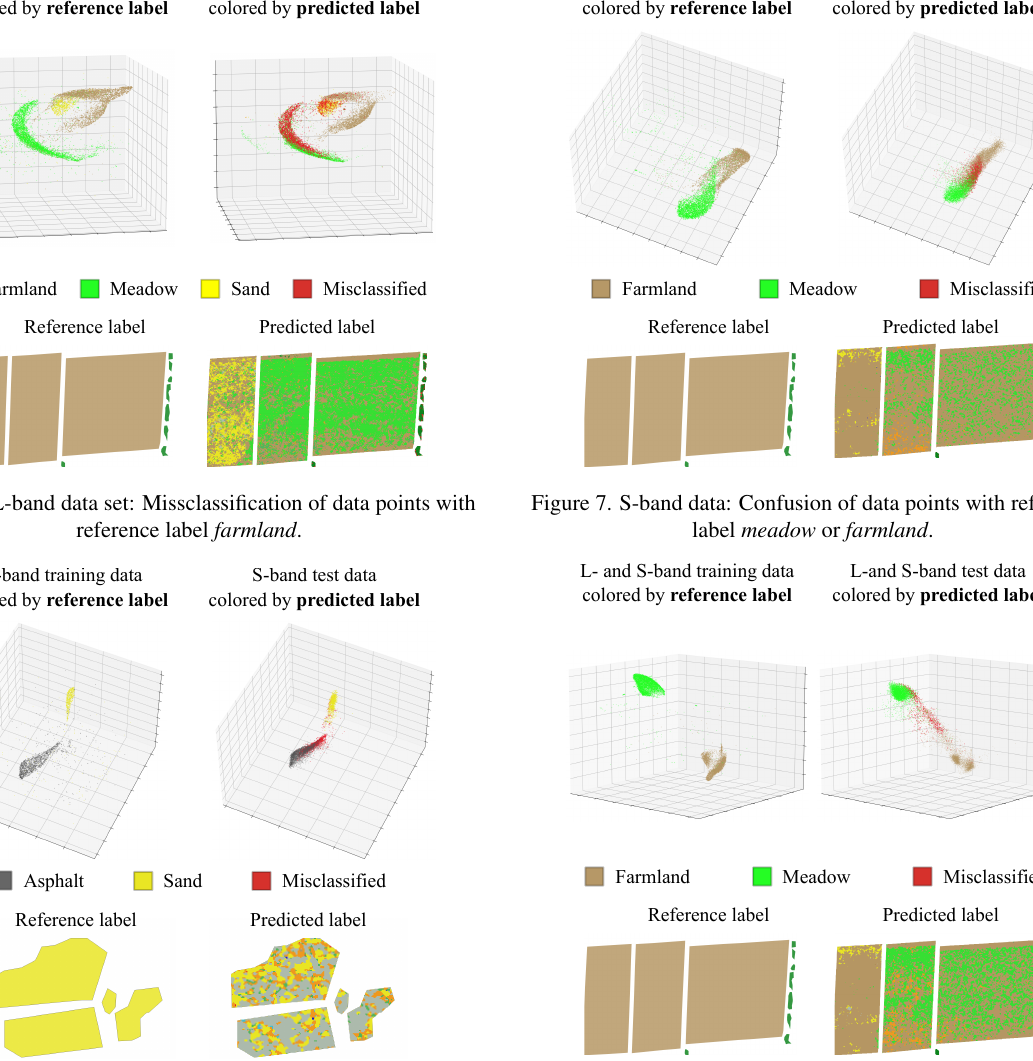
Figure 6. S-band data set: Missclassification of data points with reference label sand .